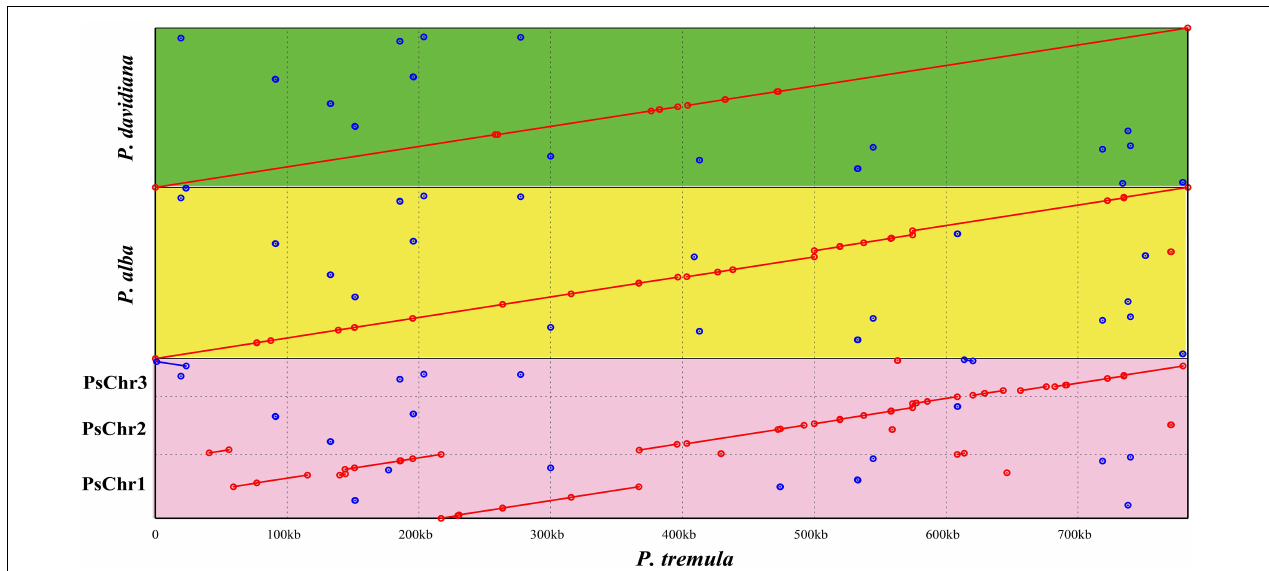
FIGURE 3 | Mitogenomic syntenic analyses among four Populus species. The P. tremula mitogenome was set as reference. PsChr1, PsChr2, and PsChr3 represent the three circular chromosomes of P. simonii mitogenome. The green, yellow, and pink rectangular region represent the syntenic regions of P. tremula vs. P. davidiana , P. tremula vs. P. alba , and P. tremula vs. P. simonii , respectively. The red and blue lines refer direct and inverted syntenic regions,